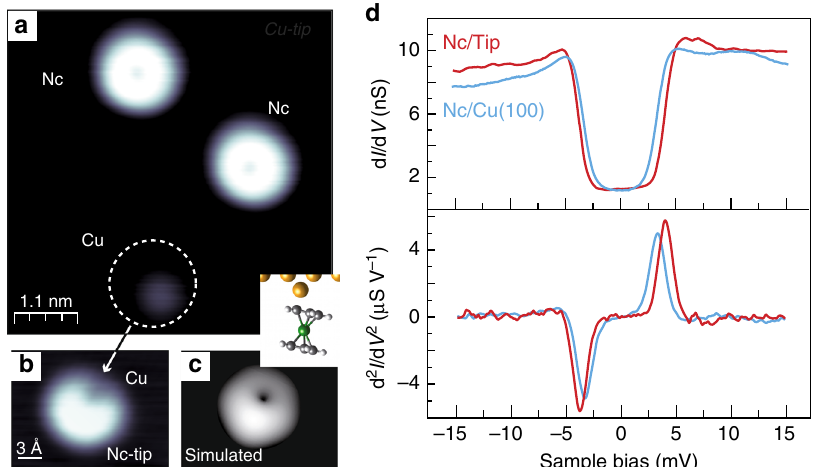
Fig. 1 Nickelocene adsorption on Cu(100) and on the tip apex. a STM image acquired with a metallic tip (5.6 × 5.6 nm 2 , − 15 mV, 20 pA). b Counter image of the Cu atom obtained with a Nc-terminated tip (1.7 × 1.3 nm 2 , − 15 mV, 20 pA). c Calculated relaxed con fi guration of a Nc molecule on top of a Cu adatom on Cu(100), together with the simulated STM image. Atom colors: Cu (yellow), C (gray), H (white) and Ni (green). d dI/dV spectra and their derivative acquired with a Cu-tip over a Nc molecule (solid blue line) and with a Nc-terminated tip over the Cu(100) surface (solid red line). Feedback loop opened at 100 pA and − 15